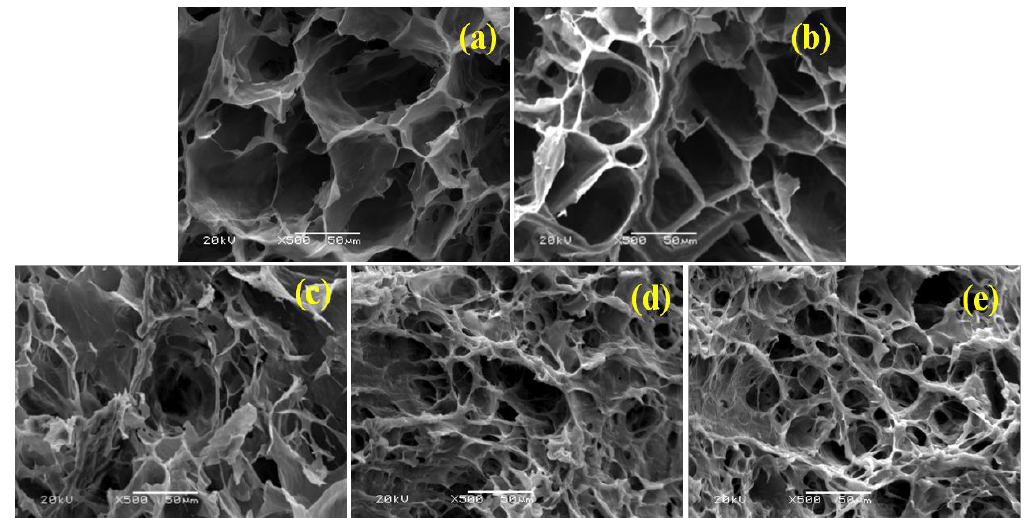
Figure 5. SEM images of SA/PVA with different GO loadings: ( a ) neat SA/PVA; ( b ) GO1-SA/PVA; ( c ) GO3-SA/PVA; ( d ) GO5-SA/PVA; ( e ) GO7-SA/PVA.